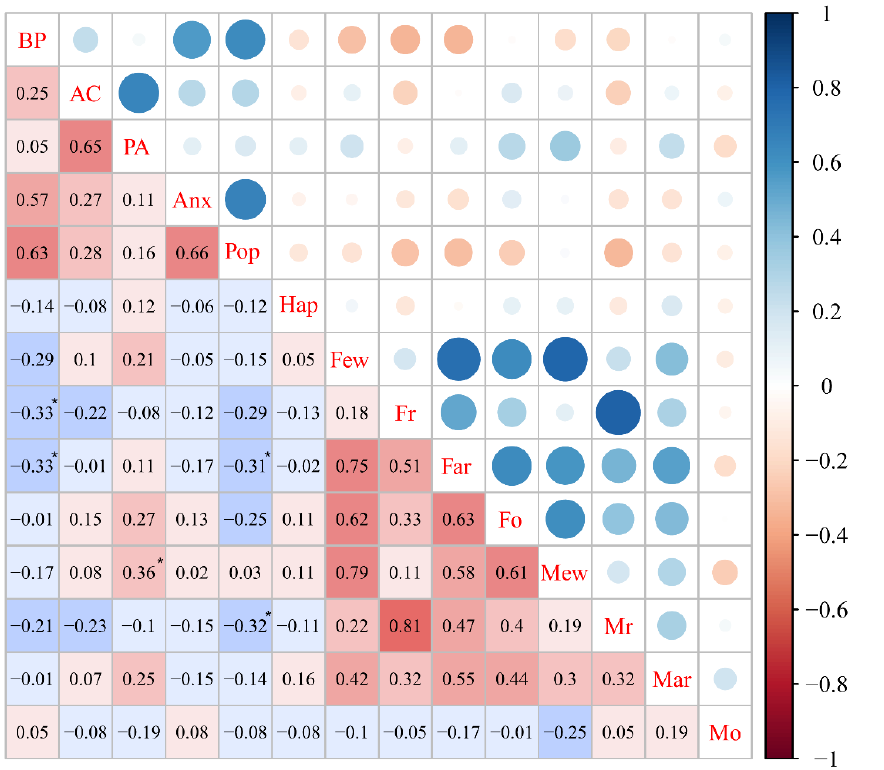
Figure 3. The relationship between self ‐ concept and parental rearing style in the dyslexic